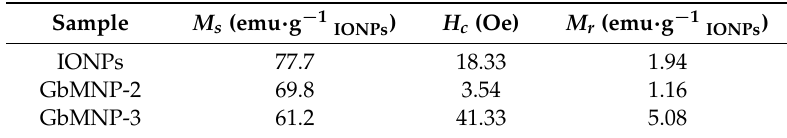
Figure 4. The magnetization curves of ( a ) IONPs; ( b ) GbMNP-2 and ( c ) GbMNP-3. Hysteresis loops at 27 °C up to ±20 kOe; the inset corresponds to the zoom in the low field region. Table 3. The magnetic properties of the uncoated IONPs and as-synthesized GbMNPs: saturation magnetization ( M s ), coercivity ( H c ), and saturation remanence ( M r ).